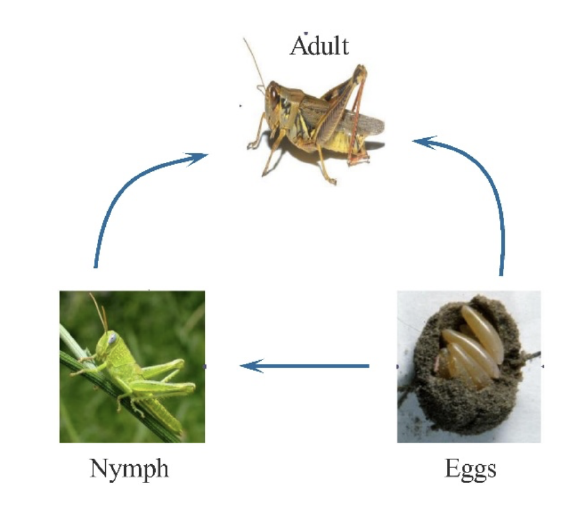
Fig. 5. The life cycle of grasshoppers